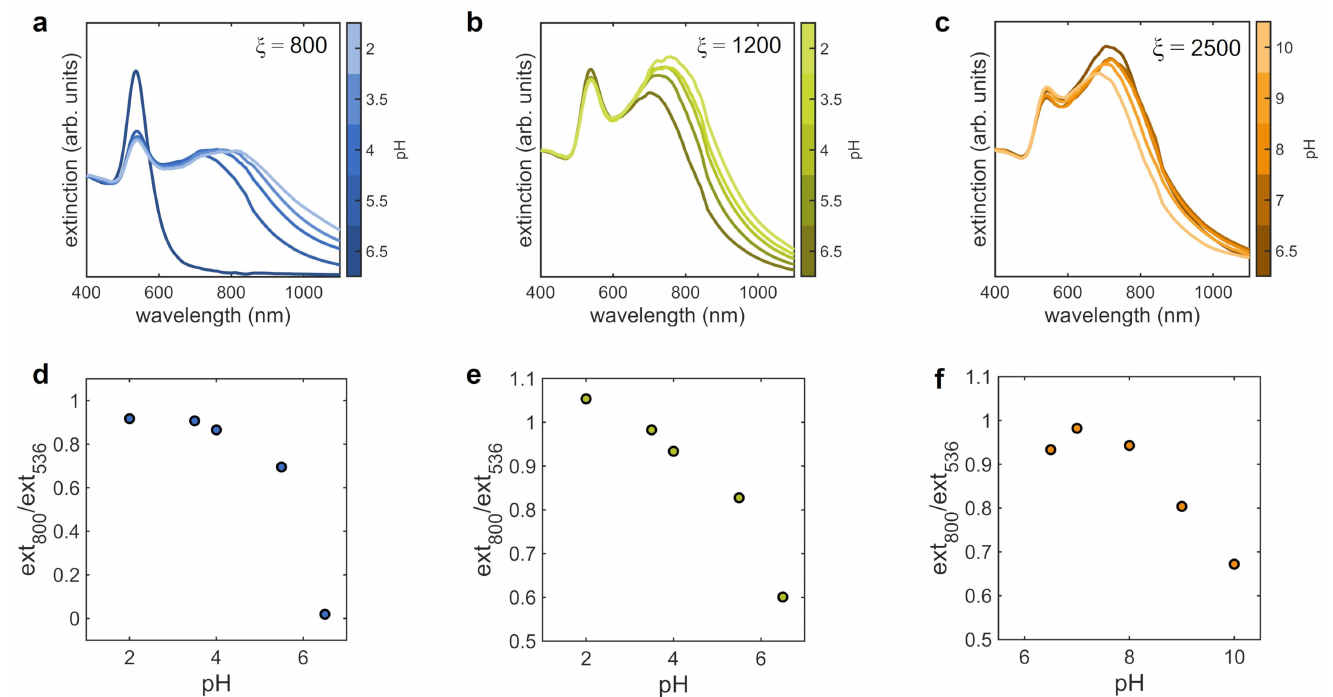
Figure 5. Optical properties of the AuNPs clusters at varying the pH of the solution for the three lysozyme-AuNPs number ratios analyzed, ξ = 800, ξ = 1200 and ξ = 2500. ( a – c ) Extinction spectra at varying pH; ( d – f ) calibration curves as a function of pH, derived from the extinction spectra by the ratio between the extinction values at 800 and 536 nm. The temperature was kept at 25 °C during